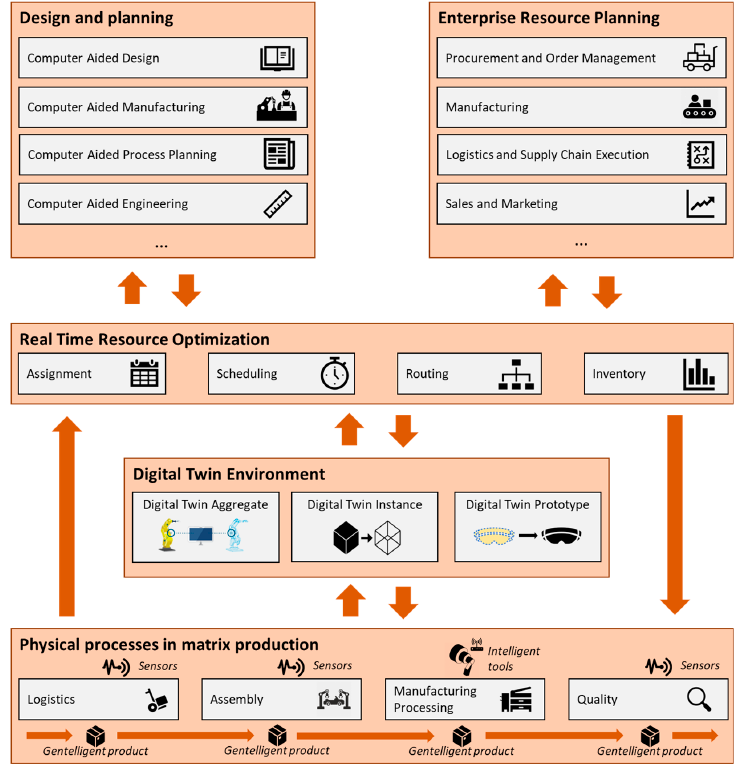
Figure 7. Structure of real-time resource optimization in matrix production.